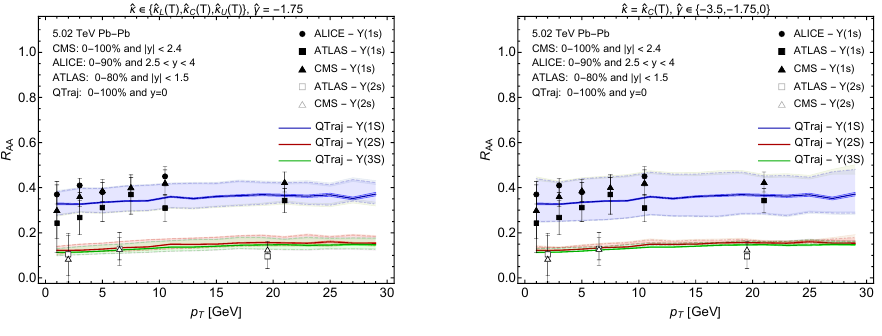
Figure 1. Nuclear modification factor R AA of the ⌥ (1 S ), ⌥ (2 S ), and ⌥ (3 S ) as a function of p T compared to experimental measurements. The experimental data are taken from the ALICE [38], ATLAS [39], and CMS [36] collaborations. The bands in the theoretical curves indicate variation with respect to ˆ  ( T ) (left) and ˆ γ (right). The central curves represent the central values of ˆ  ( T ) and ˆ γ , and the dashed and dot-dashed lines represent the lower and upper values, respectively, of ˆ  ( T ) and ˆ γ . Taken from Ref.